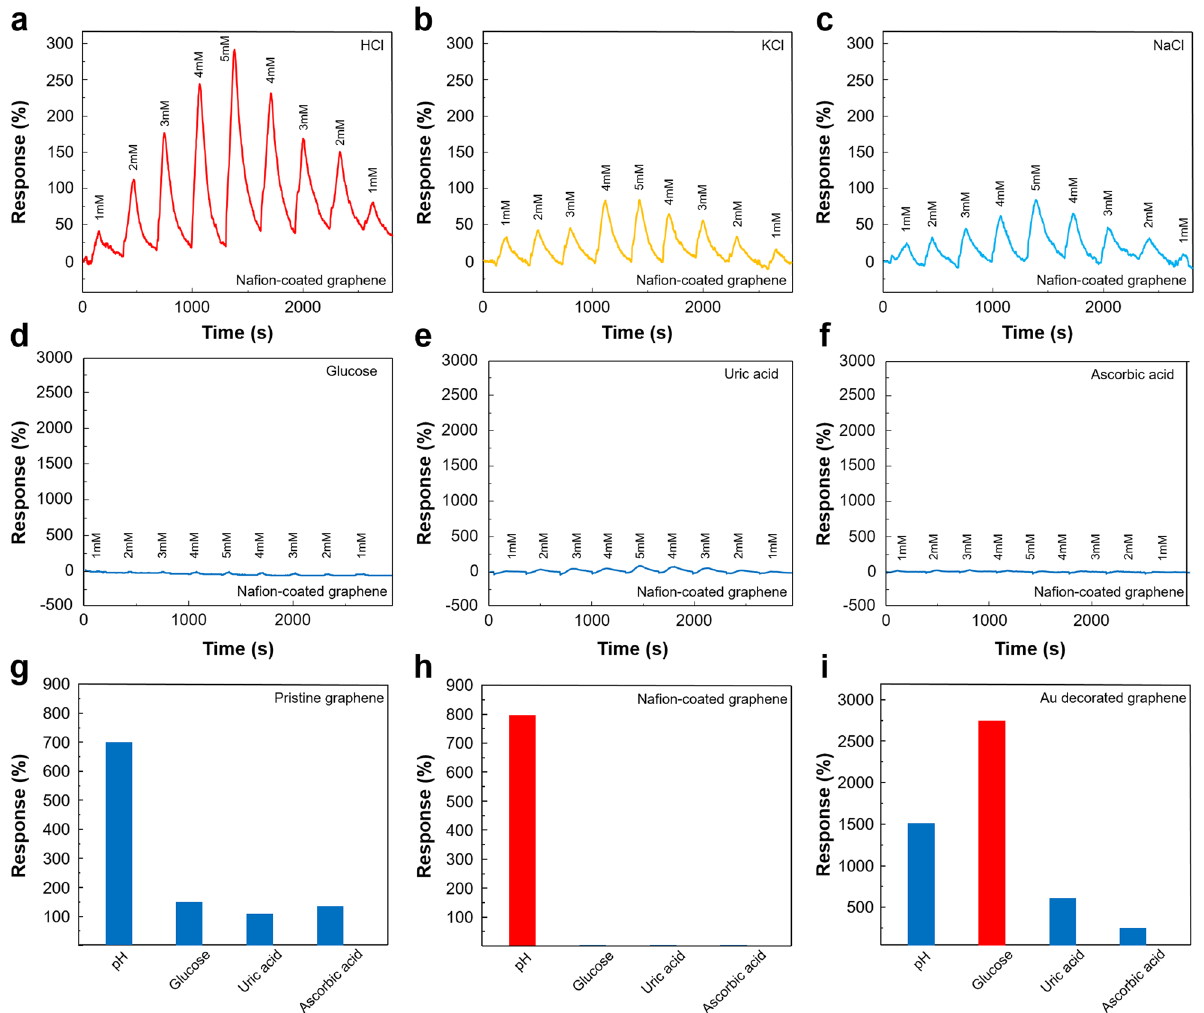
Fig. 6 Selectivity tests of Na fi on-coated graphene and results of the three types of SFETs. Selectivity test of Na fi on-coated graphene. a HCl, b KCl, and c NaCl solutions were tested with identical concentrations of 1 – 5 mM. d Glucose, e uric acid, and f ascorbic acid solutions were also tested to de fi ne the selectivity of Na fi on-coated graphene. Response results to pH (8.05), glucose (5 mM), uric acid (5 mM), and ascorbic acid (5 mM) of g pristine graphene, h Na fi on-coated graphene, and i Au-decorated